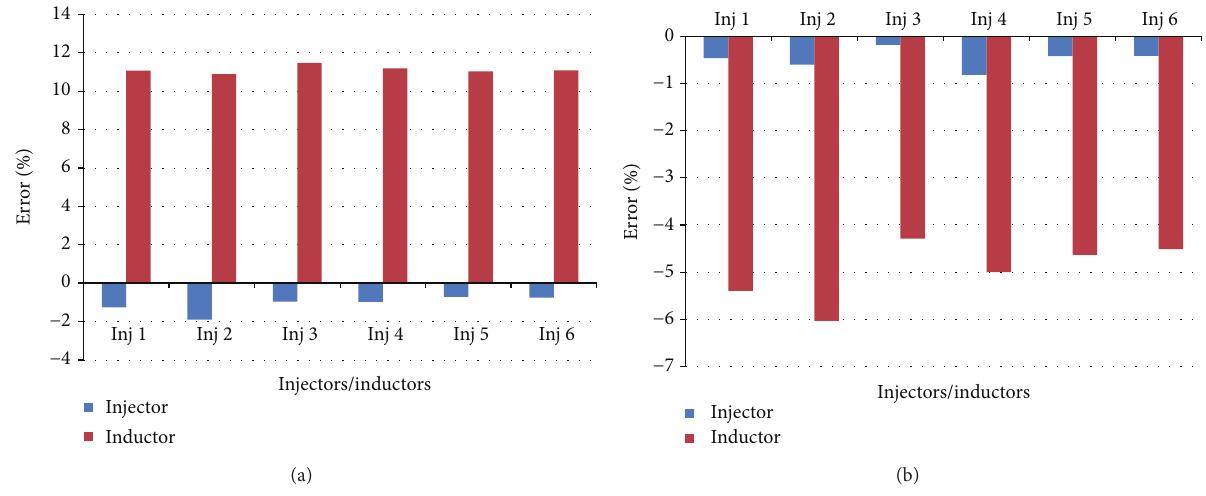
Figure 5: (a) Mean error (%) using single threshold at 0V. (b) Mean error (%) using single threshold at 3 V.